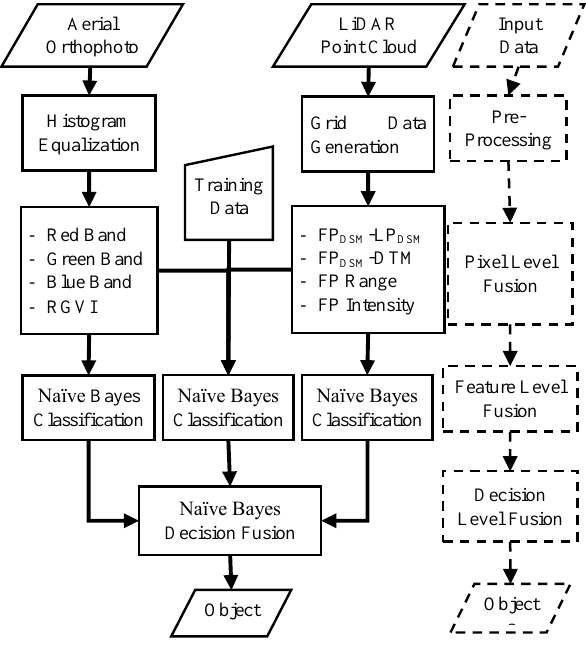
Figure 1. Flowchart of the proposed